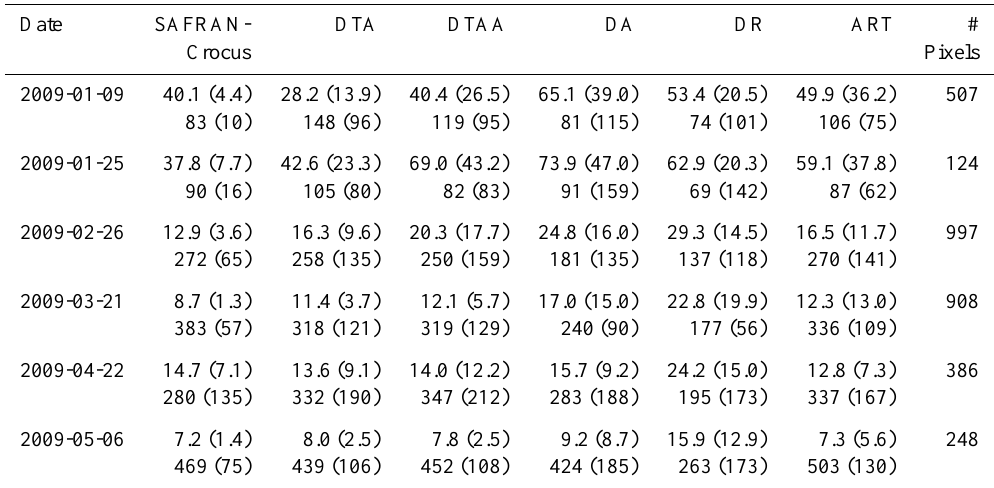
Table 6. Retrieved SSA, on first line (m 2 kg − 1 ), and optical radius, on second line (µm), for the different methods over the six studied dates. The standard deviations are provided in